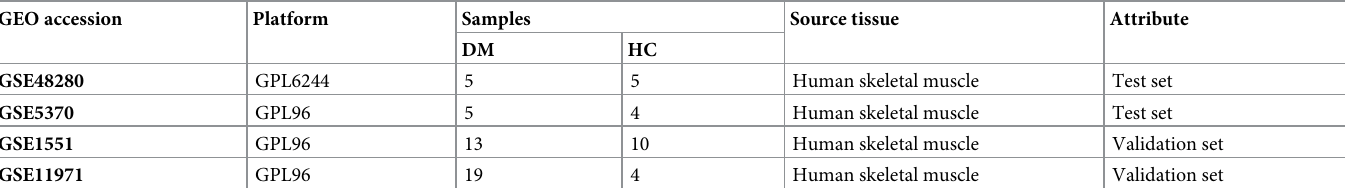
Table 1. Information for selected microarray